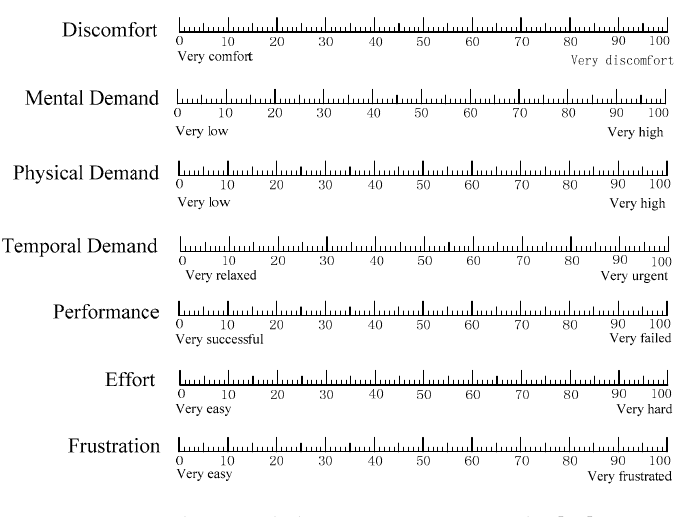
Figure 4. The extended NASA-TLX rating scales [19].